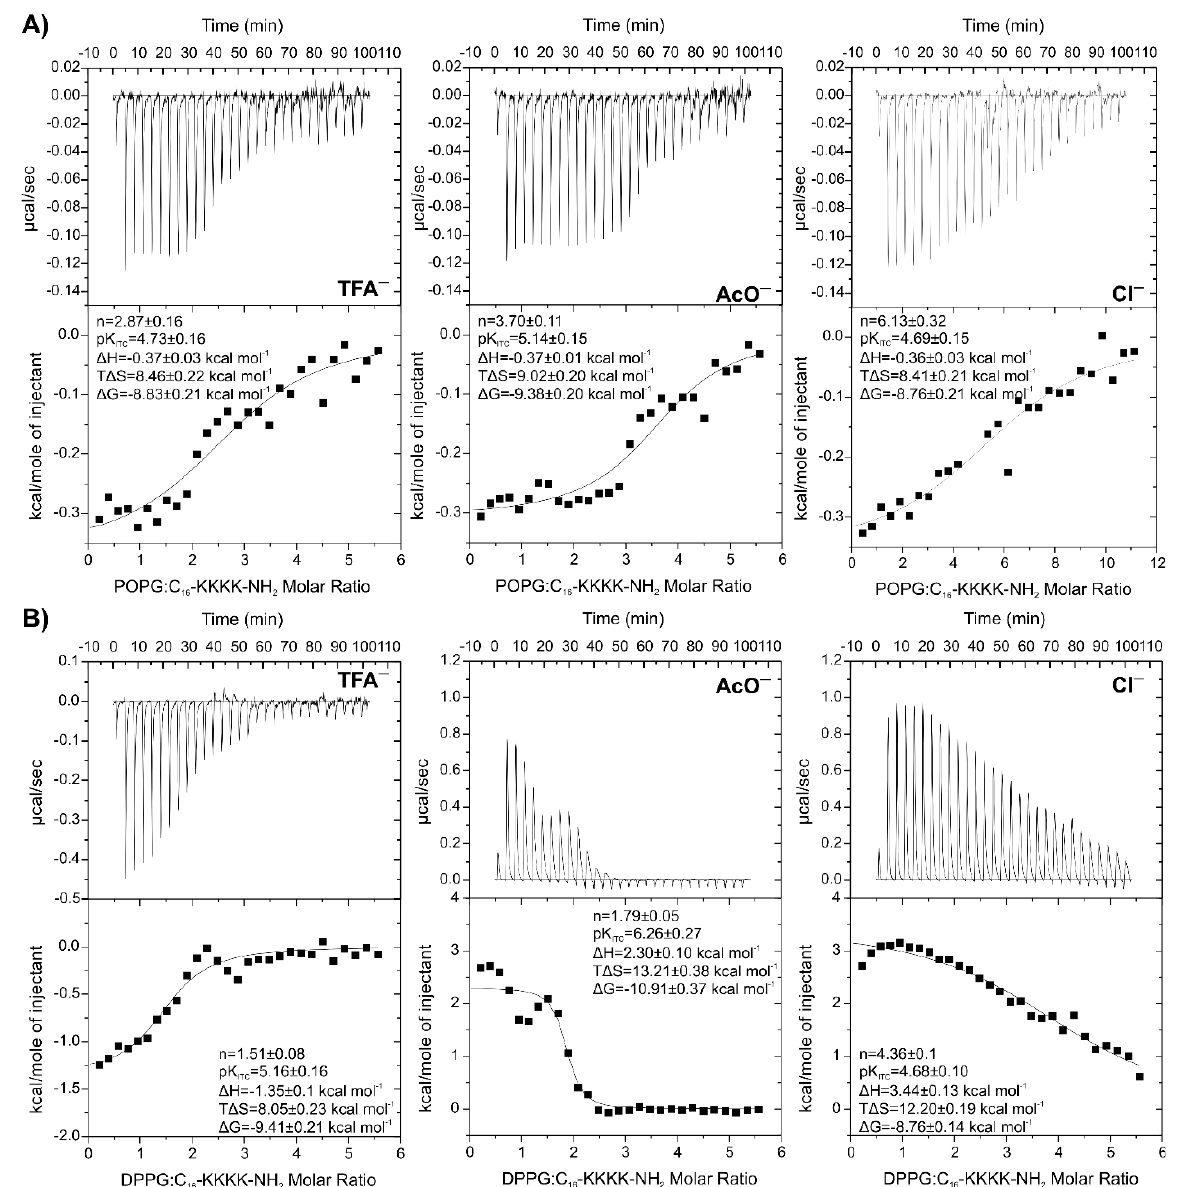
Figure 3. ITC traces showing the heat changes upon titration of ( A ) 1.3 mM POPG to 0.05 mM or 0.025 mM C 16 -KKKK-NH 2 solutions and ( B ) 1.3 mM DPPG to 0.05 mM C 16 -KKKK-NH 2 solution at 298.15 K after exchange of the counterions from trifluoroacetate (TFA − ) to acetate (AcO − ) and chloride (Cl − ). The bottom curves represent the heat of reaction vs. the lipid/lipopeptide molar